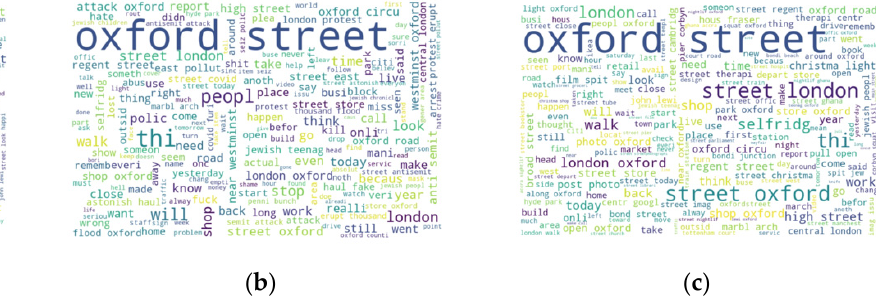
Figure 2. Word cloud visualisation of ( a ) tweets with positive, ( b ) negative and ( c ) neutral senti- ment.